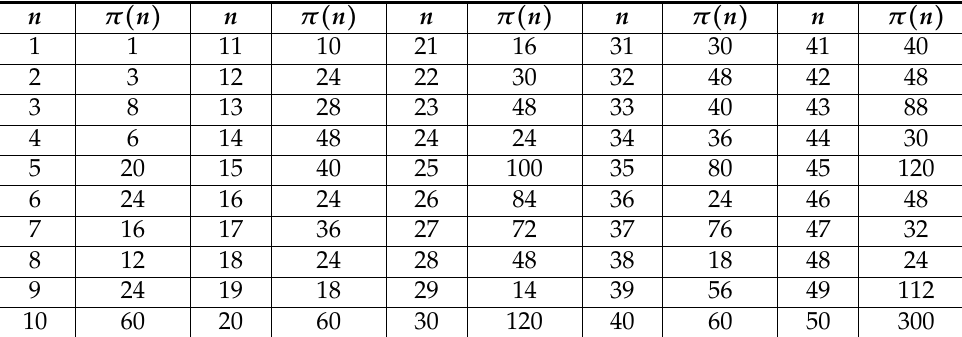
Table 2. Values of π ( n ) for n from 1 to